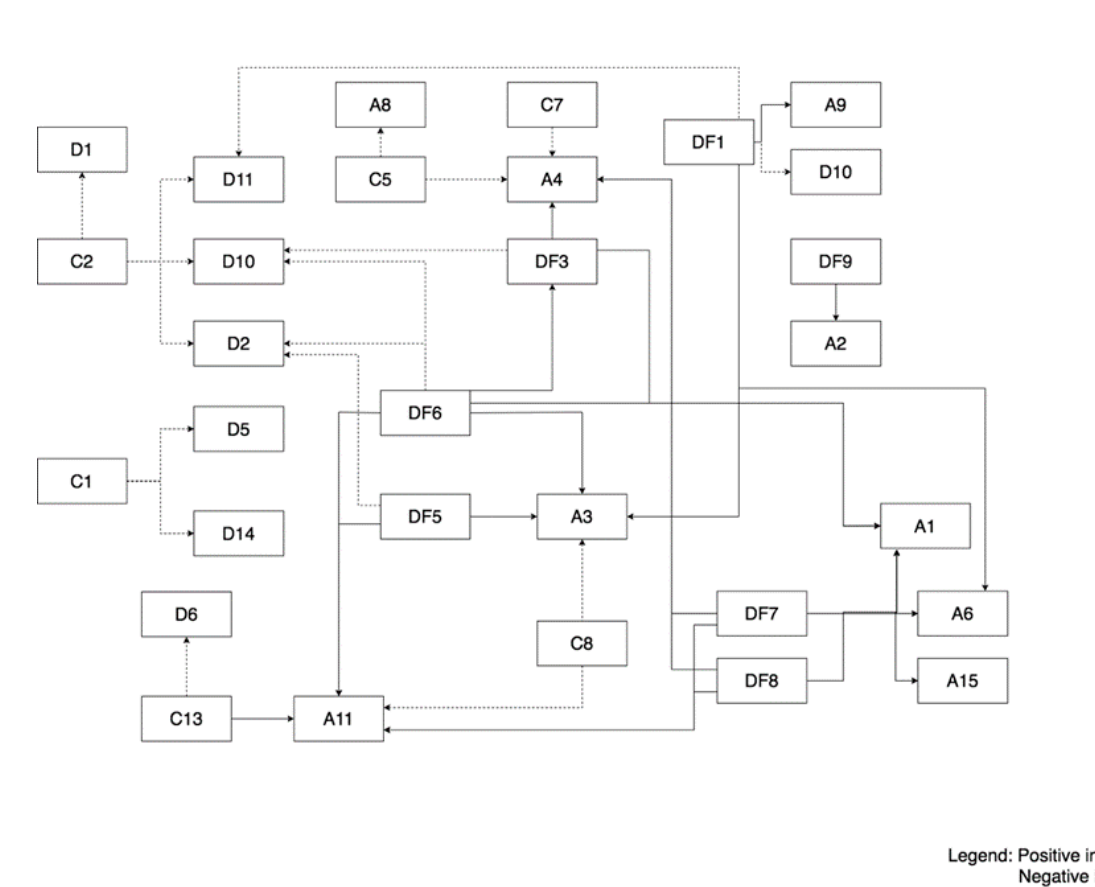
Figure 5. Tuned decision factors relation based on interviewees’ feedback.